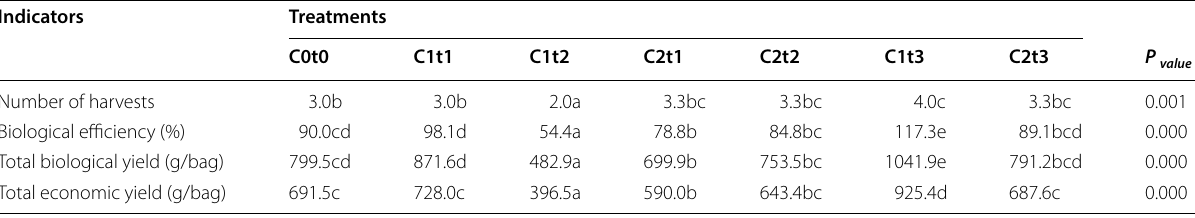
Values are means; means within the same row followed by the same letters are not significantly different at P < 0.05 according to Duncan’s multiple range test, ns: non-significant